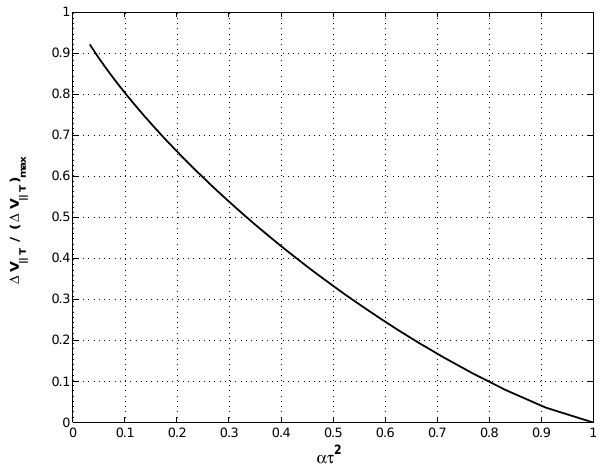
Fig. 2. Effective width (over parallel velocities) of trapped particle region, normalized to its maximum value 8 /πkτ , as the function of dimensionless parameter ατ 2